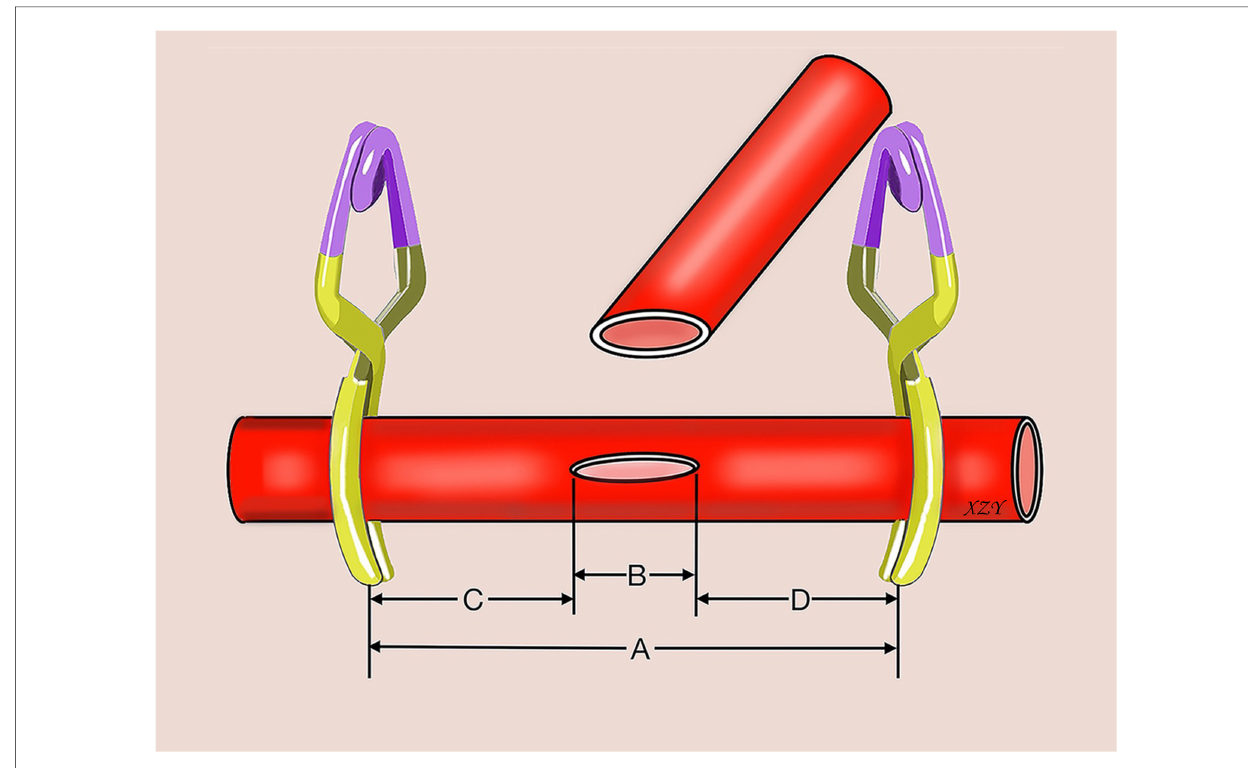
FIGURE 6 Schematic illustration shows the measurements in end-to-side anastomosis using rat common iliac arteries. ( A ) distance between two aneurysm clips; ( B ) length of the arteriotomy or venotomy; ( C ) distance between the proximal aneurysm clip and the proximal end of the arteriotomy or venotomy; ( D ) distance between the distal aneurysm clip and the distal end of the arteriotomy or venotomy.